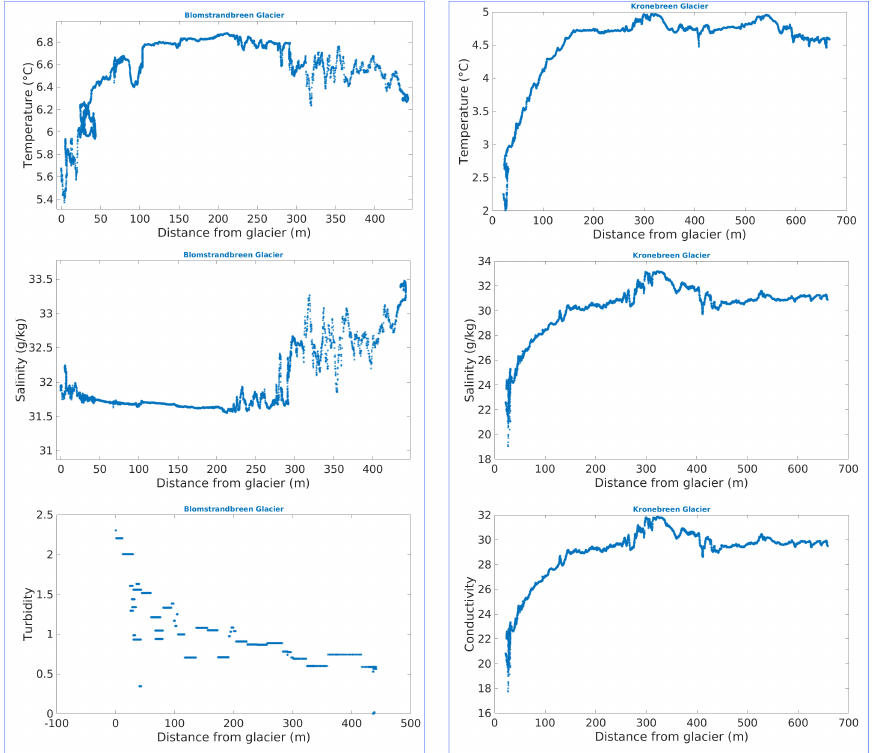
Figure 18. Trend of different water parameters as a function of the distance from the front of two glaciers (Blomstrandbreen left side and Kronebreen right side) acquired by CTD